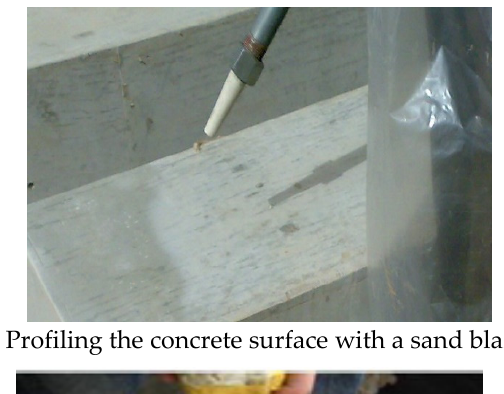
Table 2. Tensile properties of steel reinforcement and CFRP sheets.